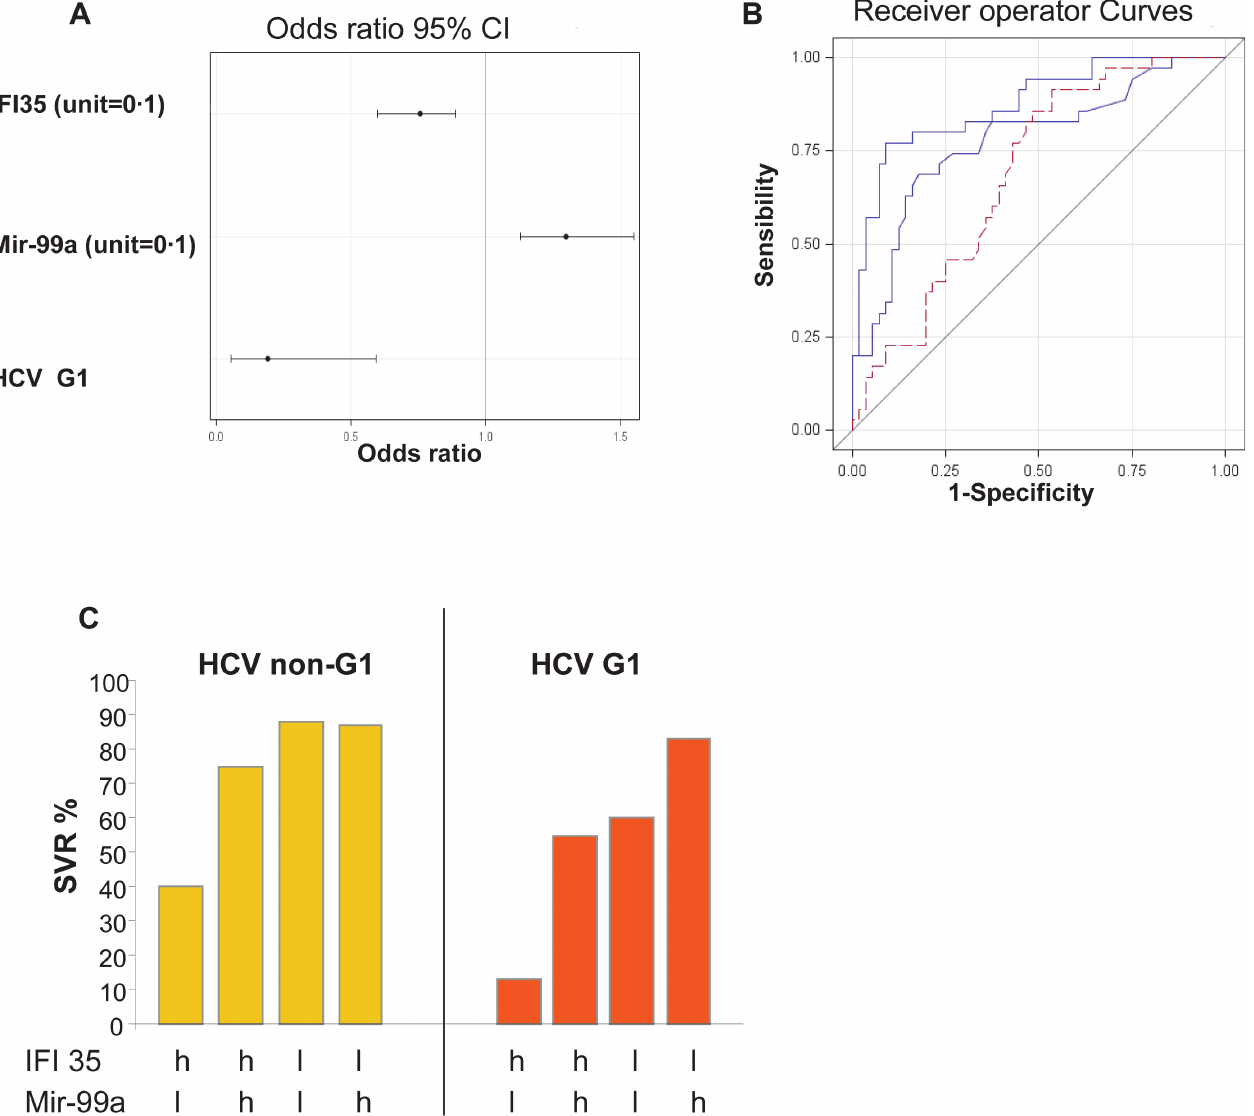
Fig 5. Identification of a signature predicting SVR. Clinical, miRNAs and mRNAs expression data were analyzed by multivariate analysis. 5A- ORs are presented for the 3 variables of the signature: mir-99a, IFI35 and HCV genotype 1. 5B- Receiver Operator Curves for prediction of viral response of the signature (AUC 0.876) (genotype 1, IFI35 and mir-99a expression) based on IFI35 expression (AUC 0.777) and mir-99a (AUC 0.688). 5C- Schematic representation of the prediction of SVR. Patients with genotype non-1 had high SVR rates when they express low level of IFI35 (l for low, < mean IFI35 expression). HCV genotype 1 infected patients with low level of IFI35 and high level of mir-99a (h for high, > mean mir-99a expression) showed high SVR